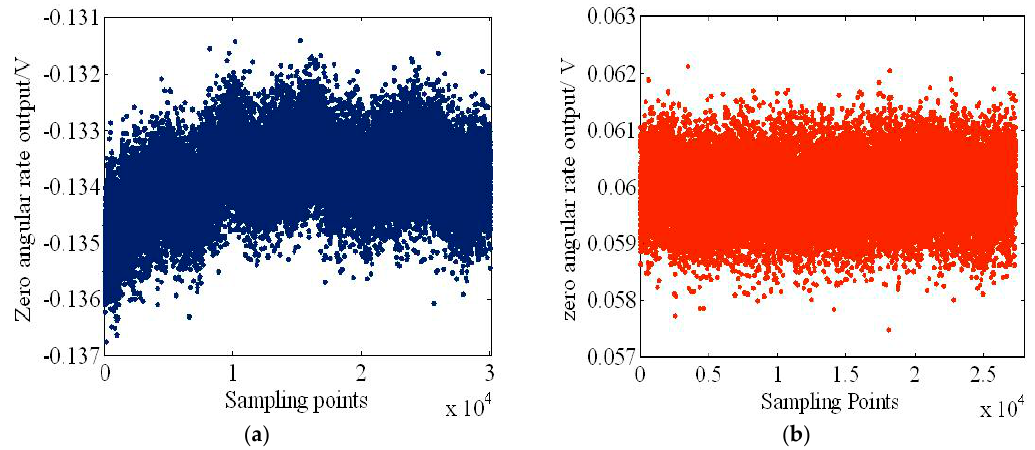
Figure 14. Time slice of the recorded zero angular rate output ( a ) without and ( b ) with oscillation suppression electronics.